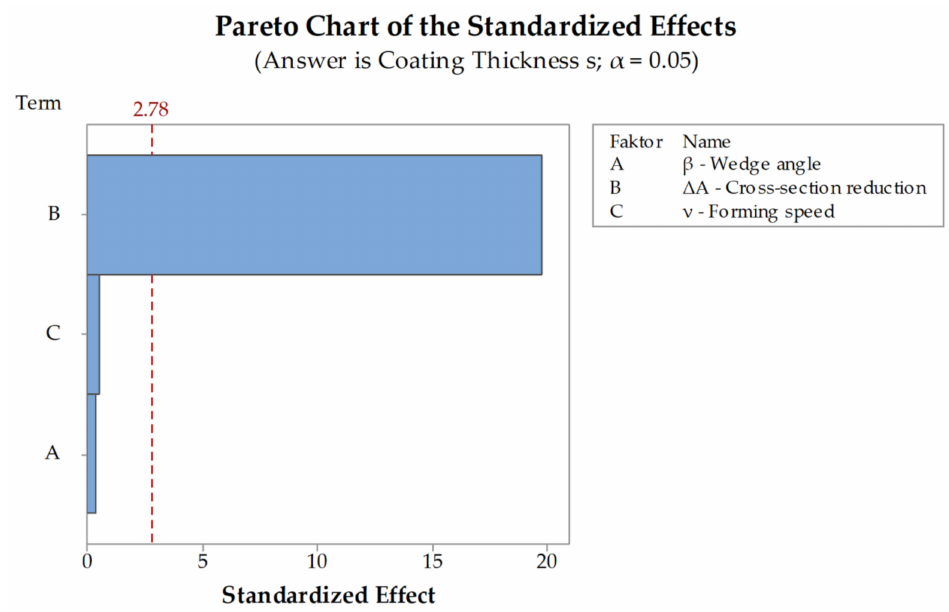
Figure 13. Pareto Chart of the Standardized E ff ects for the coating thickness s in the experimental trials. To be able to determine the way the coating thickness changes with a change of the investigated parameters it is necessary to examine the main e ff ects plot (Figure 14). The plot shows that with an increasing cross-section reduction the coating thickness decreases from s = 1.34 mm at ∆ A = 20% to s = 0.84 mm at ∆ A = 70%. Since the wedge angle and the forming speed are not significant to the coating thickness after CWR, there is only a minimal di ff erence between β = 4 between ν = 60 mm / s and ν = 240 mm / s.